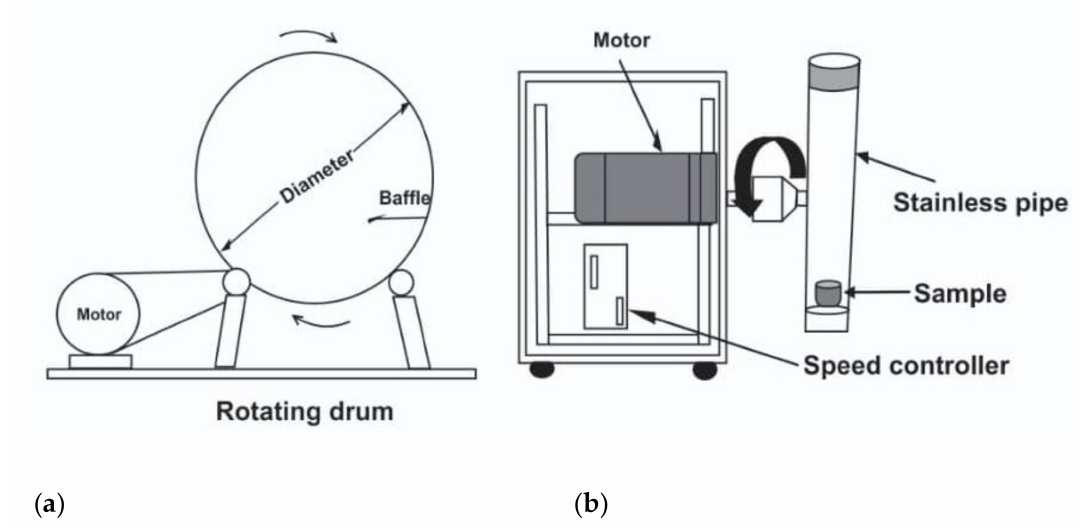
Figure 6. ( a ) Rotating drum adapted from [7] and ( b ) schematic of a tumbler adapted from [126]. Severy, et al. [127] placed nine briquettes in a 572 mm diameter cylindrical tumbler rotating at 21 rpm for 5 min. After tumbling, all the material remaining on a 50.8 mm mesh sieve was weighed as the durable fraction of the briquettes. Tumuluru, et al. [128] in their study tumbled 10 briquettes in a tumbling durability tester for 3 min at 40 rpm. ¸Tenu, Roman, Senila, Ro¸sca, C â rlescu, B ă etu, Arsenoaia, Dumitrachi, and Corduneanu [125] used a rotating drum of 598 mm in length and 598 mm diameter. The drum was rotated at 21 rev/min for a total of 5 min. The durability of the briquettes was expressed as a ratio of the initial weight of the briquette to its final weight not passing a 45 mm